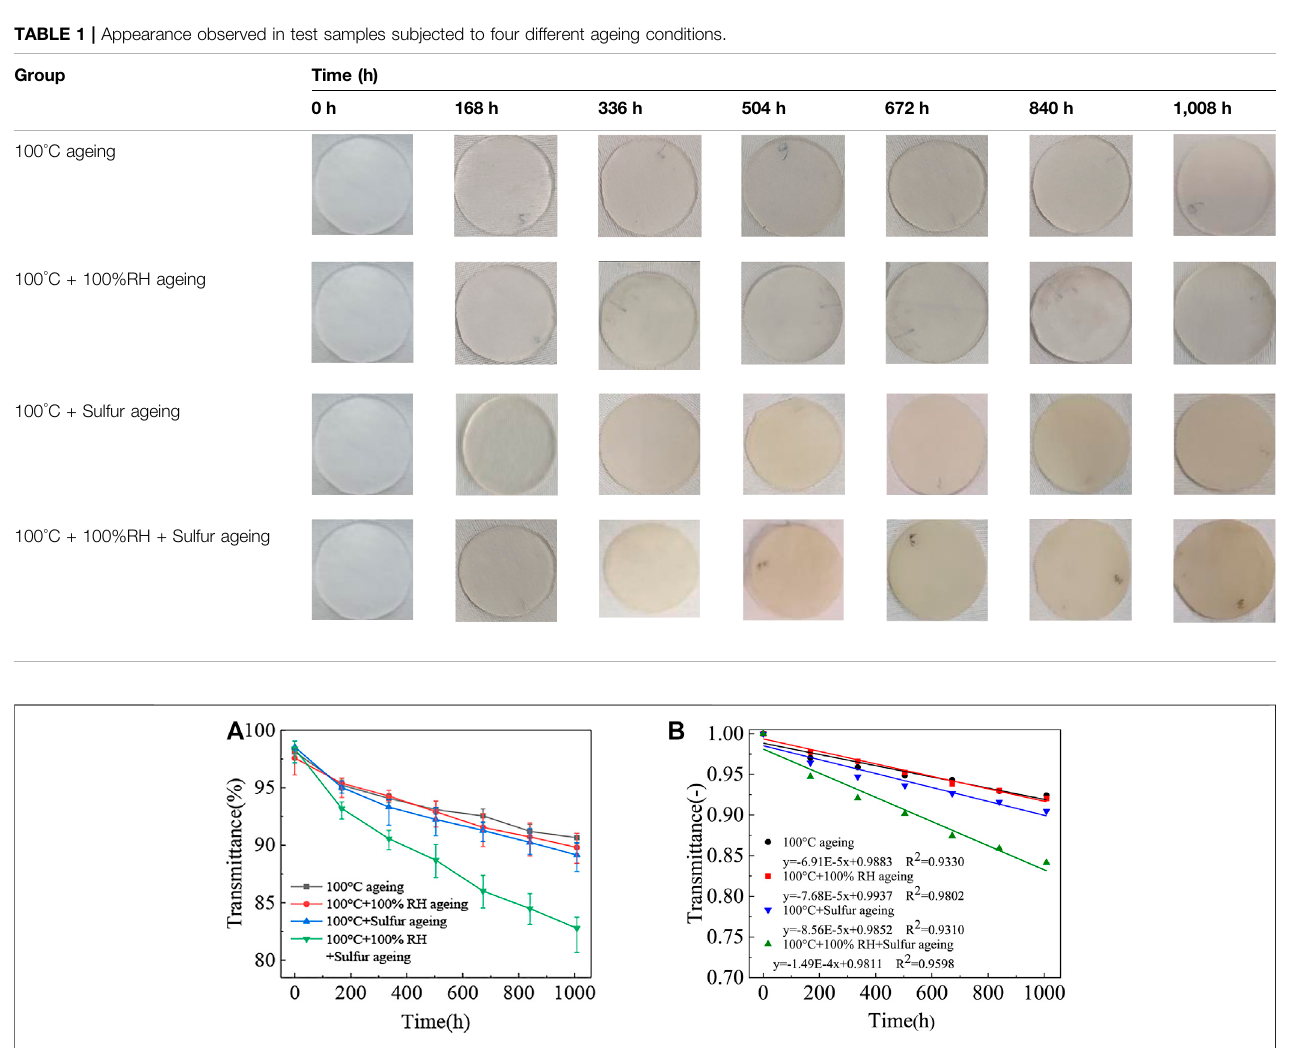
Frontiers in Materials |